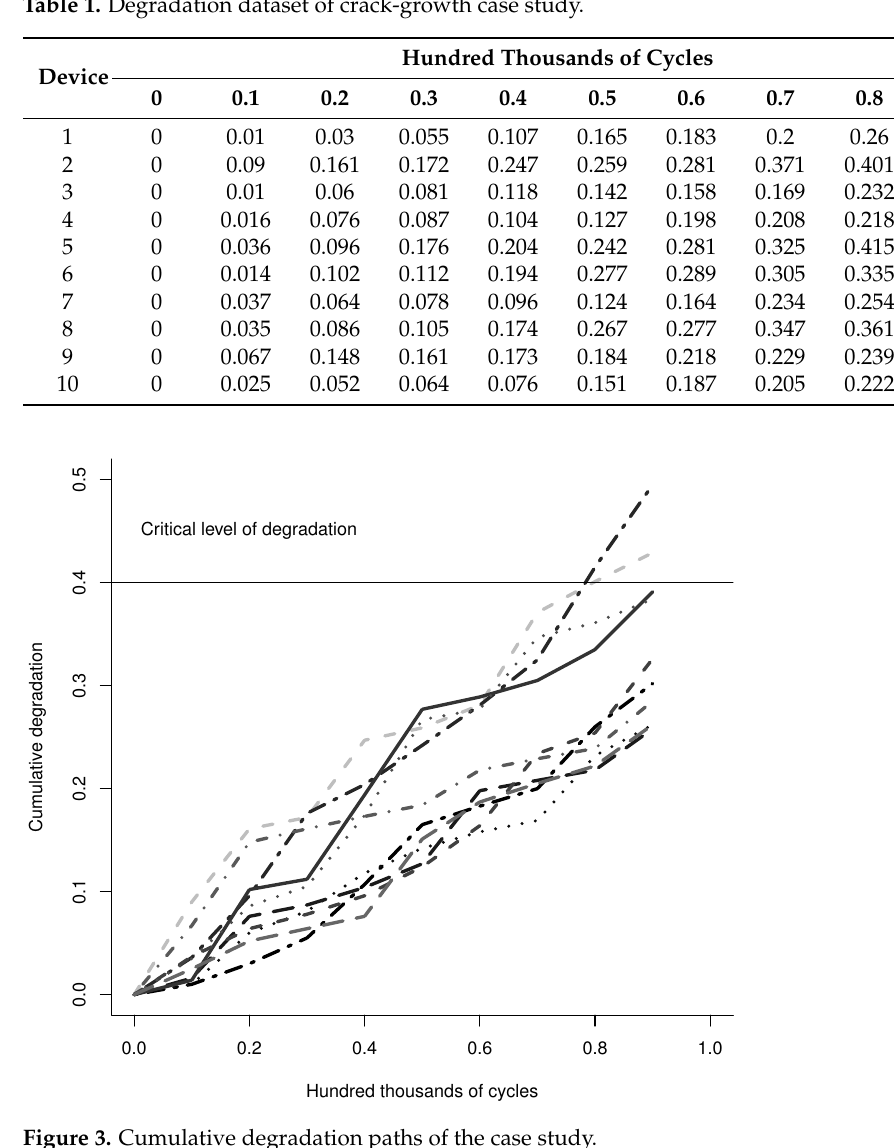
Table 1. Degradation dataset of crack-growth case study.